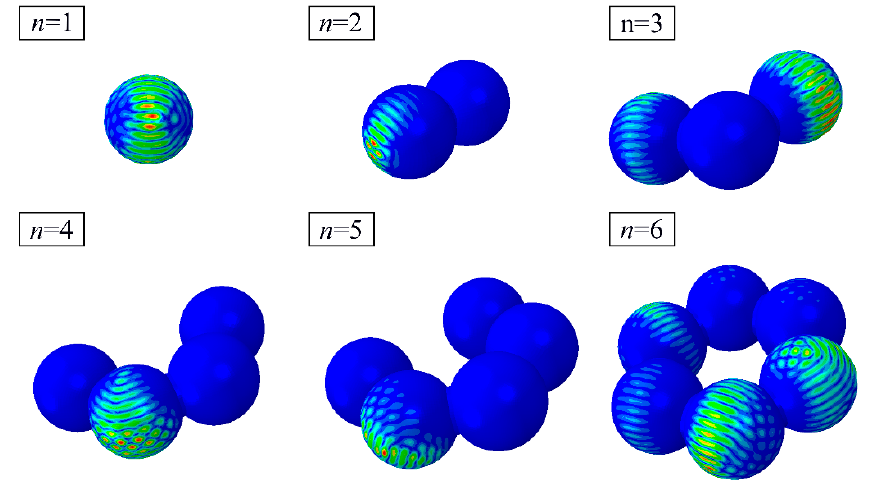
Figure 16. First-order eigenmode of sphere-segmented toroidal shells with a segment number of 1–6.